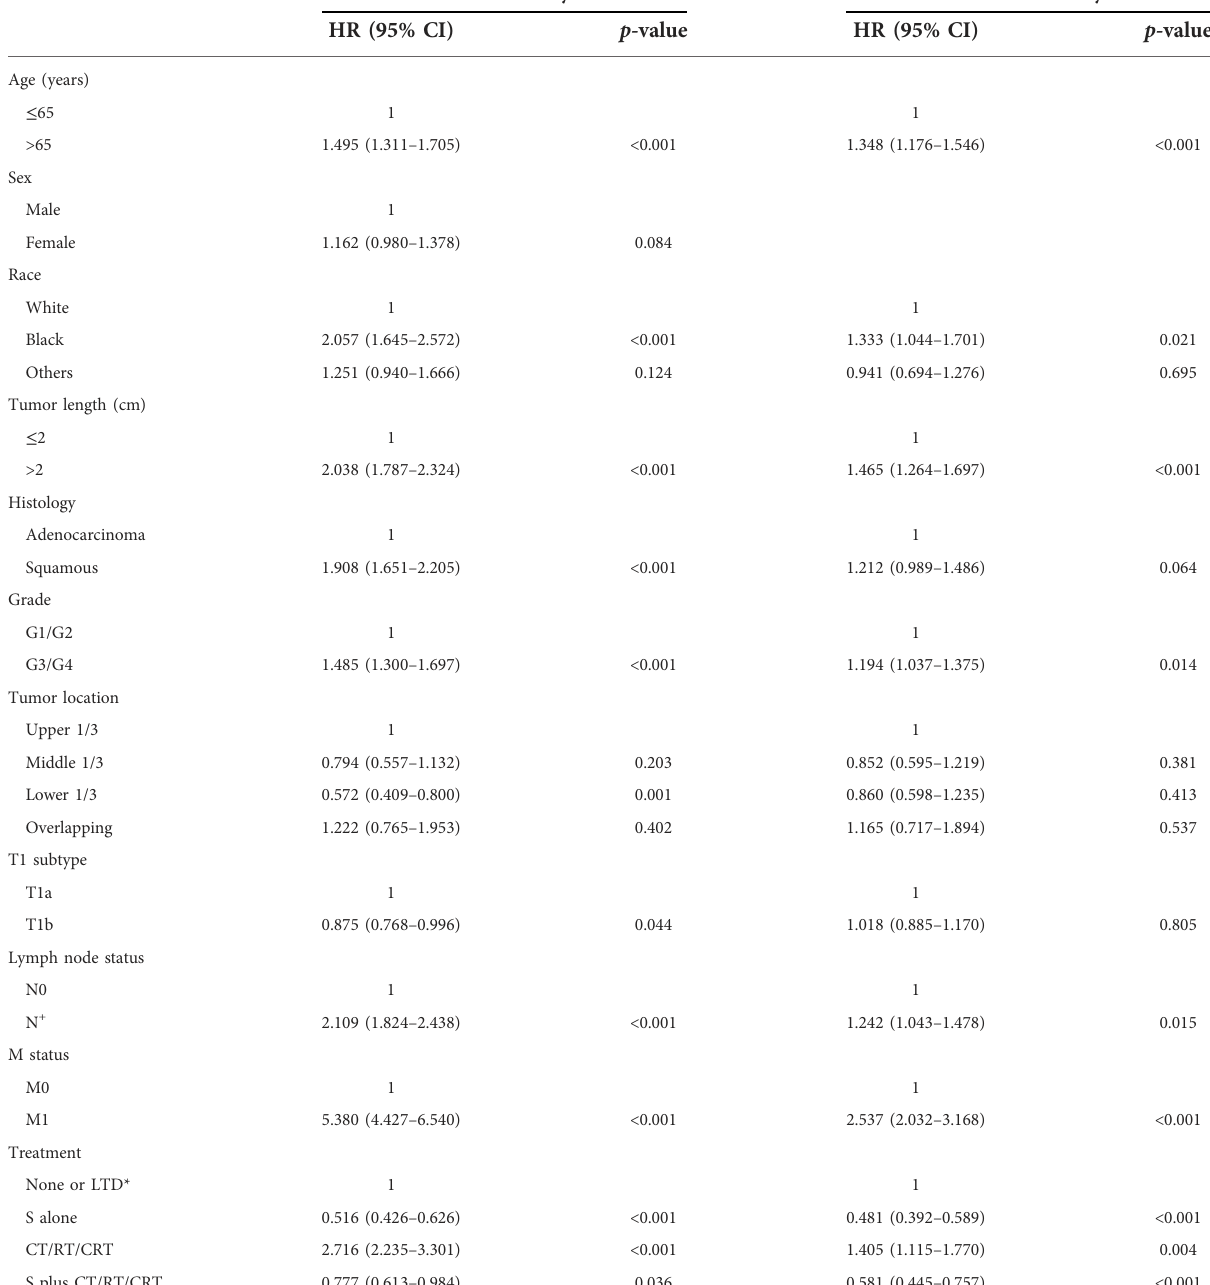
TABLE 3 Cox regression analysis of the risk factors for OS in patients with survival